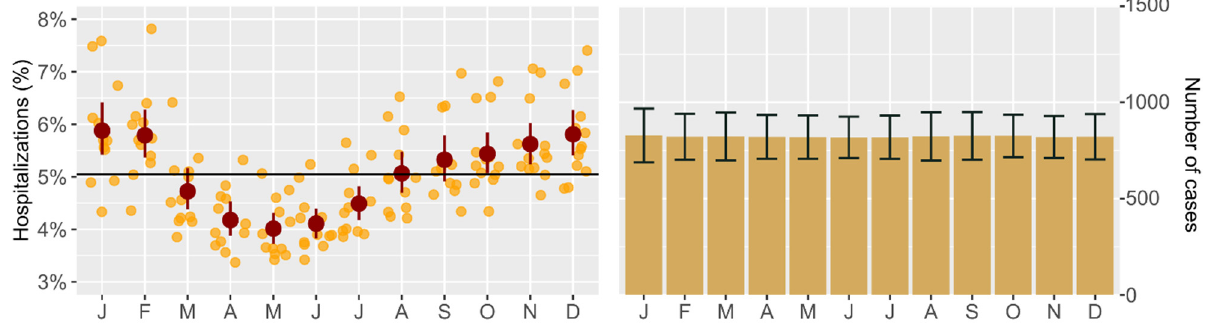
Figure 5. Monthly estimates of total hospitalizations due to fires in terms of percentage and in total number of inpatients.